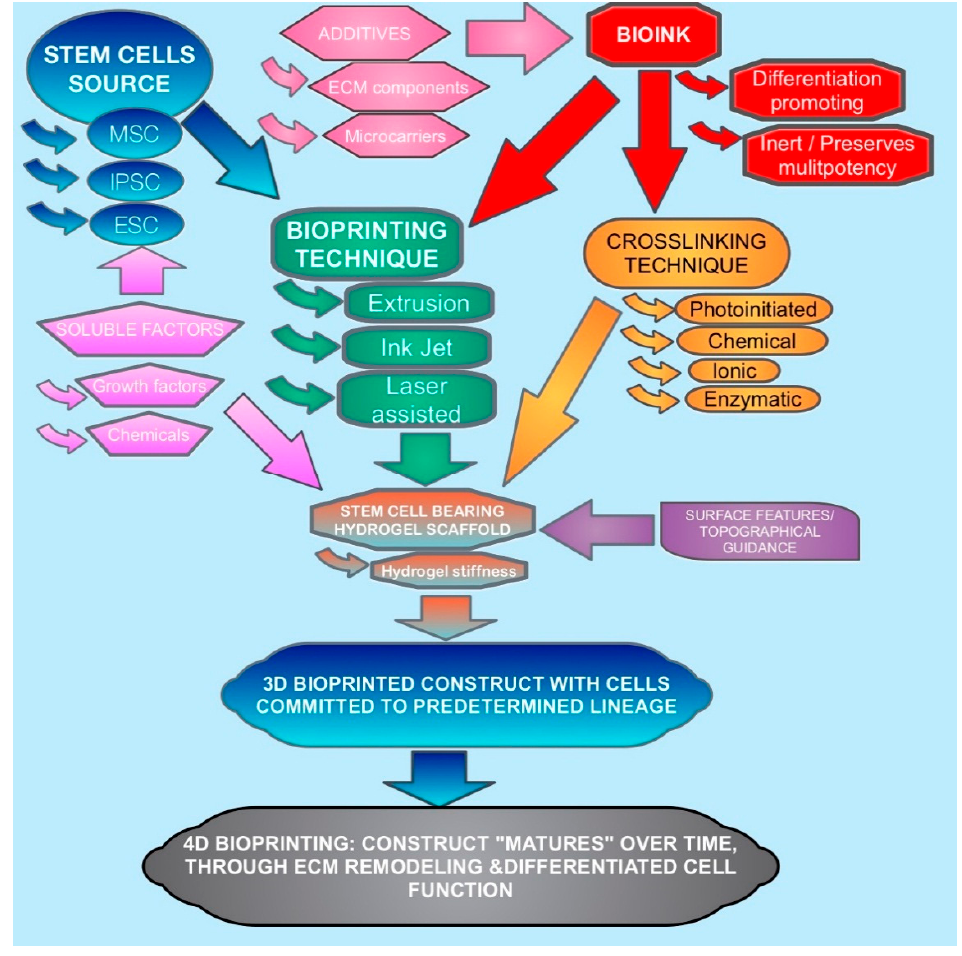
Figure 1. Diagram demonstrating interplay of the factors and variables involved in the 3D bioprinting and differentiation of stem cells as discussed in this article.